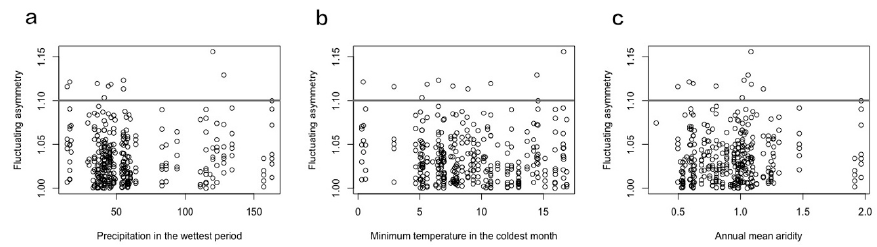
Figure 4. Distributions of Q-fly fluctuating asymmetry on important environmental variables: ( a ) precipitation in the wettest month; ( b ) minimum temperature in the coldest month; ( c ) annual mean aridity. The line shows the high fluctuating asymmetry (FA) value ( M + 3 SD ): individuals above the line were defined as highly asymmetric individuals.